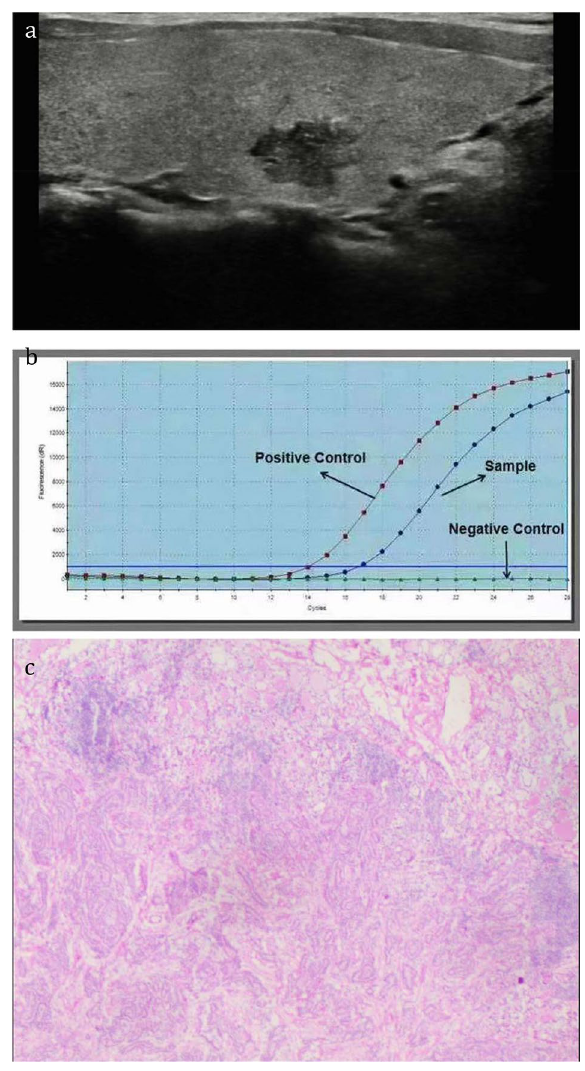
Figure 1. A thyroid nodule, assigned to Bethesda category III, was considered malignant diagnosed by the combination of TIRADS and BRAF V600E analysis. The nodule proved to be a malignant tumour confirmed by postoperative pathology. ( a ), the 2D sonogram classified as TIRADS 4b, ( b ), mutant BRAF V600E gene, ( c ), papillary thyroid